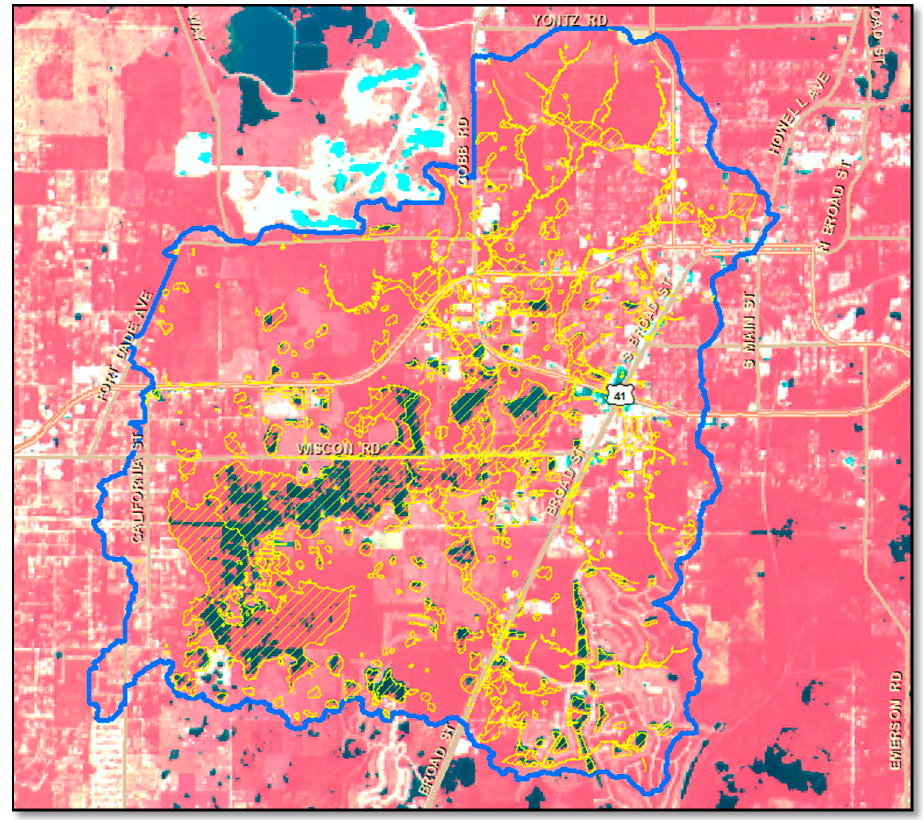
Figure 2. The Peck Sink Watershed (blue outline) showing Tropical Storm Debby modeled floodplain (yellow hatching) overlaid onto the SPOT image (scale ~ 1:65,000).